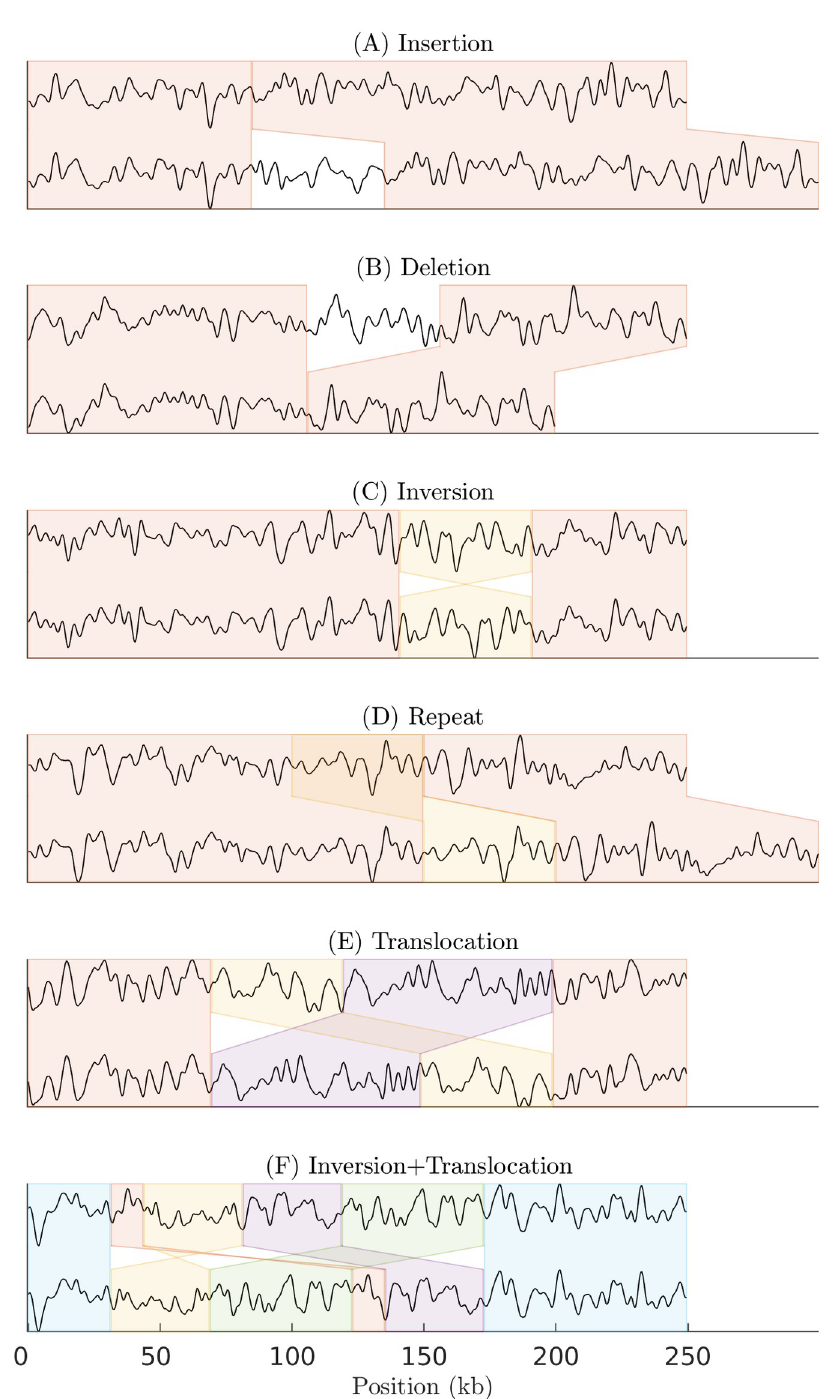
Fig 1. Schematics of the structural variations (SVs) problem using DNA barcodes. As an illustration of different types of SVs, shown here are 6 different pairs (above: reference barcode, below: query barcode) of stacked barcodes: (A) An insertion, a sub-barcode is inserted in the query barcode. (B) A deletion, a sub-barcode is deleted in the query barcode. (C) An inversion, involves flipping a sub-barcode in the query barcode. (D) A repeat, a sub-barcode is repeated two (or more) times. (E) A translocation, a sub-barcode in the query barcode is moved to a different place on the reference barcode. (F) Inversion+Translocation, a complex SV involving both flipping a sub-barcode in the query barcode and moving a sub-barcode in the query barcode to a different place compared to the reference barcode. In these examples all query barcodes are random barcodes (see Table 1) of 500 pixels ( � 250 kb) length and the SVs are 100 pixels ( � 50 kb) long. Matching sub-barcodes are enveloped in boxes of the same colour.